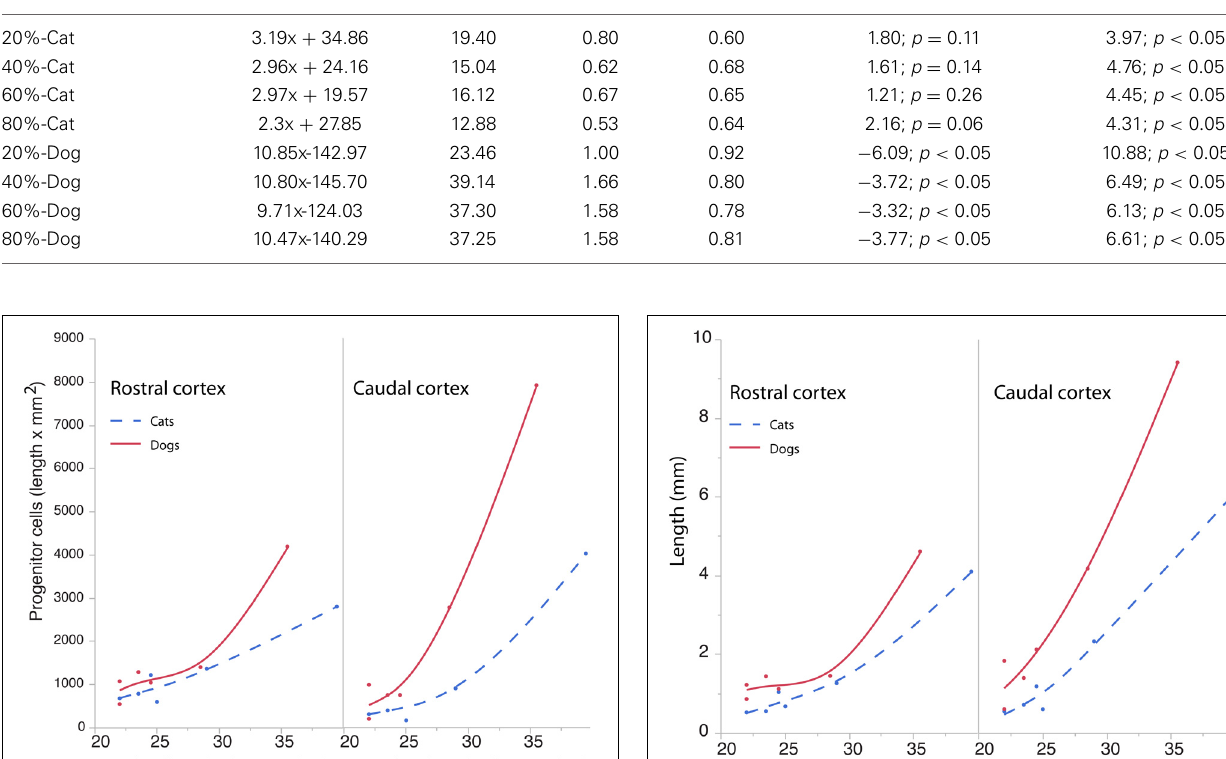
Table 5 | Summary of statistical parameters of the thickness of the proliferative zone regressed against translated age in cats and dogs. Rostro-caudal location